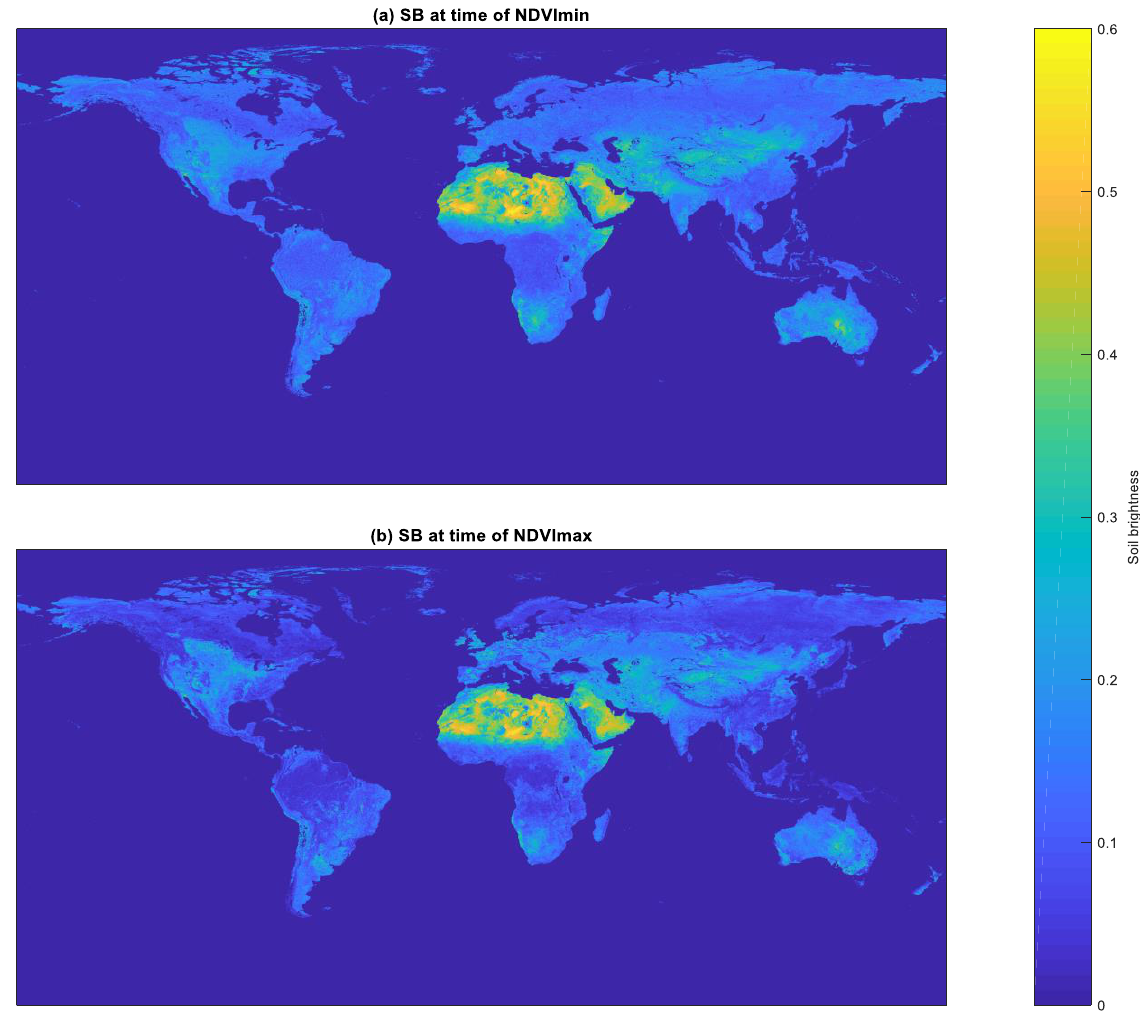
Figure 11. Estimated soil brightness (in the red band) from the DLUT applied to the red–NIR bands of the images of Figure 9.